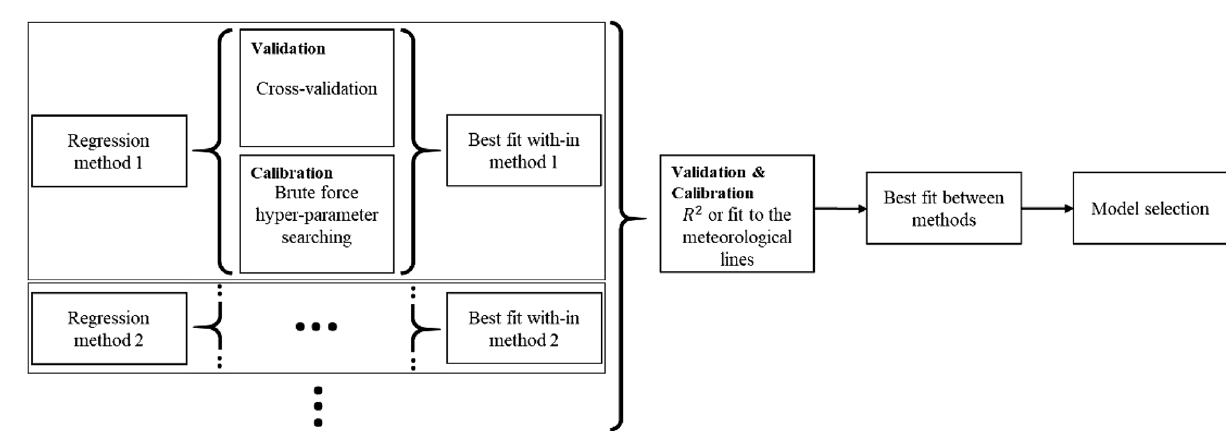
Figure 5. Feature selection flowchart of the model class. Red lines indicate false arguments.